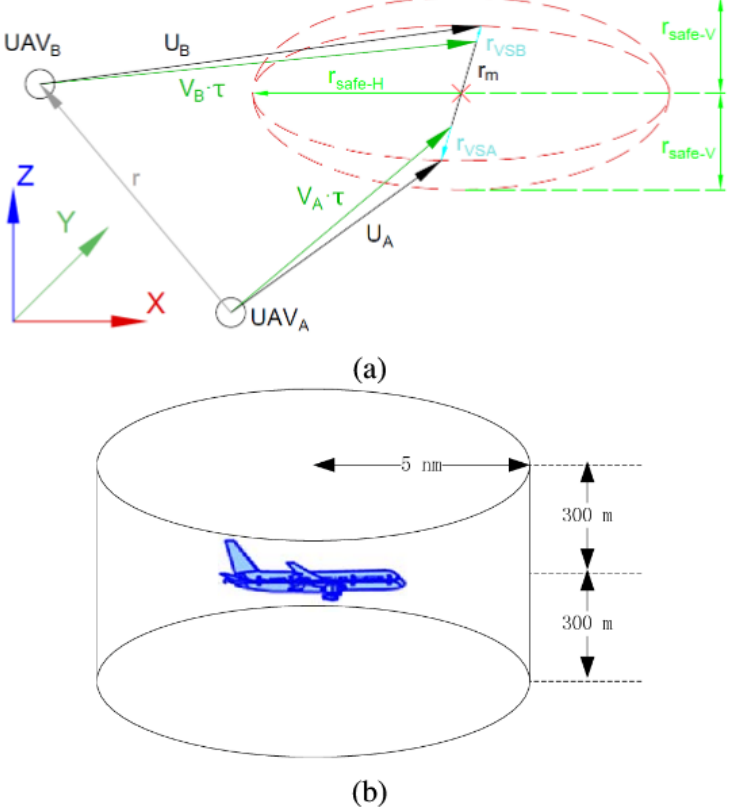
Figure 9. Examples of separation space definitions: ( a ) Spheroid safety zone and definition of used vectors in this paper, ( b ) Cylindrical safety zone from